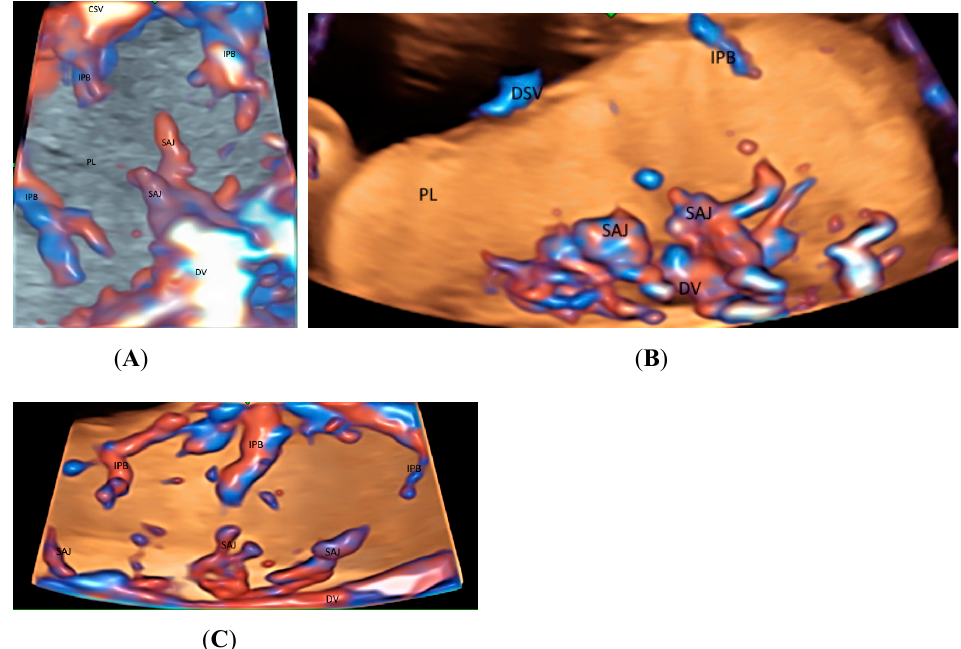
Figure 5. Three-dimensional or spatiotemporal image correlation volume acquisition in high-defi- nition flow, displayed in glass-bode mode in a normal pregnancy ( A ), in a pregnancy at an increased risk of fetal growth restriction ( B ), and in a pregnancy at a high risk of pre-eclampsia ( C ), all at 20 weeks’ gestation. In ( A ), note the spiral artery jets (SAJ) opening into the intervillous space of the placenta (PL), and the intraplacental branches (IPB) of the umbilical artery with primary and sec- ondary order branches. In ( B ), only one small primary order branch is noted without any secondary order branches. In ( C ), IPB are long but slender with few secondary or tertiary order branches. CSV, chorionic surface vessels; DV, decidual vessels; PL, placenta.